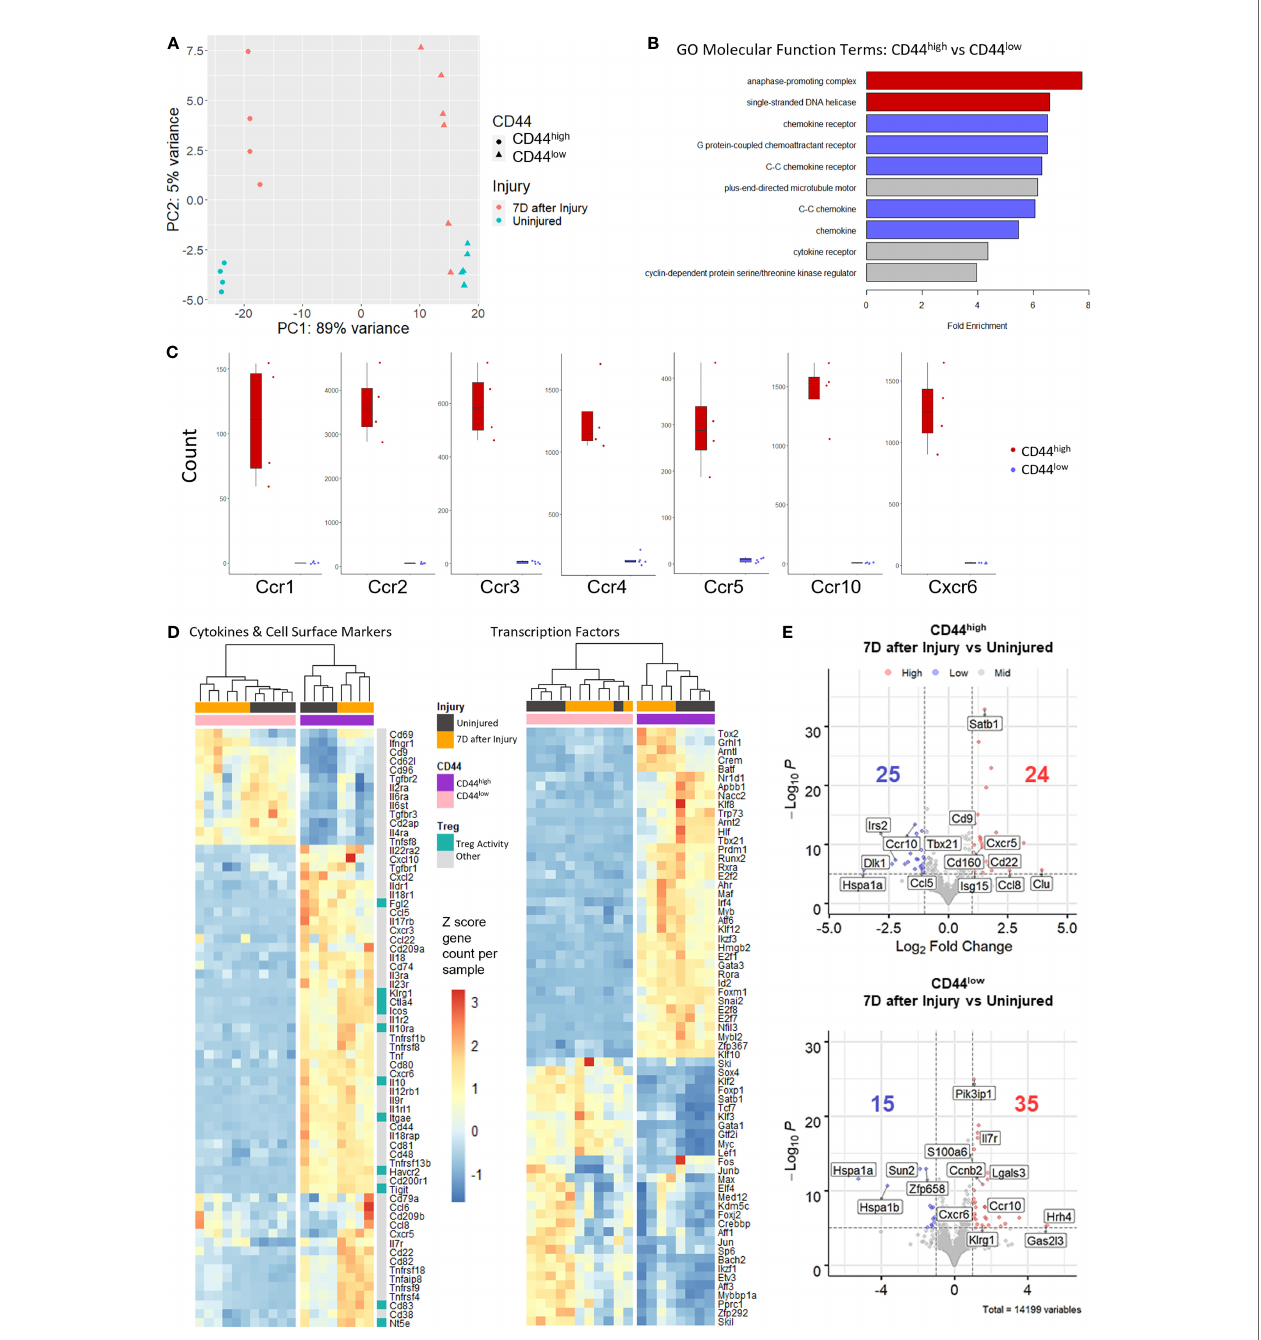
FIGURE 2 | Bulk RNA sequencing of sorted CD44 high and CD44 low Tregs from the lymph nodes of uninjured and injured mice. (A) Principal component analysis (PCA) plots demonstrating Treg subset distribution based on gene expression from uninjured and injured mice. (B) Bar plots of Gene Ontology (GO) molecular function analysis of the top 2000 genes upregulated in CD44 high versus CD44 low Tregs shows enrichment of cell division (red), chemokine receptor and chemokines (blue), and other (gray) terms. (C) Box plots illustrating the difference in chemokine receptor gene counts between CD44 high and CD44 low Tregs. (D) Gene expression levels of cytokines and cell surface markers and transcription factors (rows) in injured (black bars) and uninjured (orange bars) CD44 high (purple bars) and CD44 low (pink bars) Tregs (columns) from the top 2000 genes with the highest stabilized variance. (E) Volcano plots of injured vs. uninjured groups plotted as Log 2 -fold change of differentially expressed (DE) genes in CD44 high and CD44 low Treg subsets. Genes with a p value less than 10 -6 are colored blue if the gene shows a decrease of more than 2-fold and red if the gene shows an increase of more than 2-fold. Key DE genes are labeled. Counts of signi fi cantly up or down regulated genes are given with respective